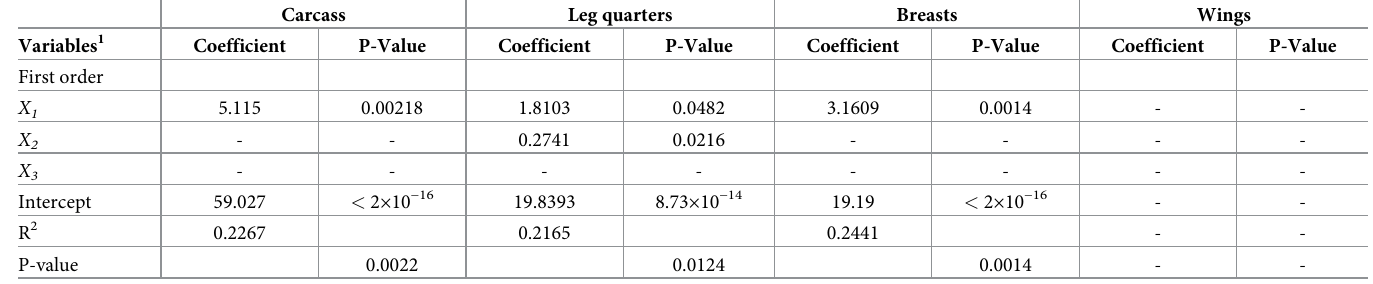
Table 9. ANOVA, coefficient estimates and summary statistics of carcass yields (% of live BW) in response to digestible lysine concentration (SID Lys), energy den- sity (AMEn) and starch to lipid ratios (S:L) in broiler chickens. Carcass Leg quarters Breasts Wings Variables 1